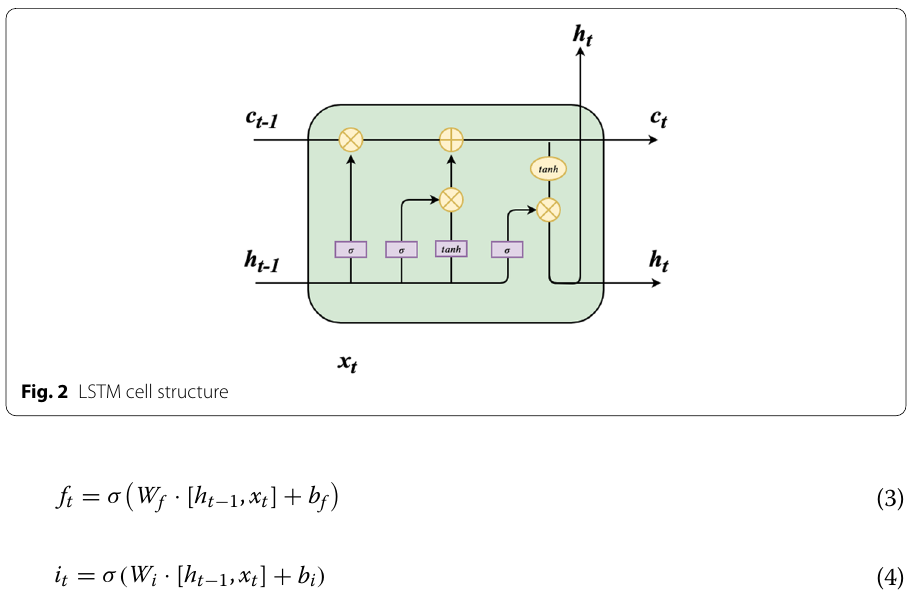
Fig. 2 LSTM cell